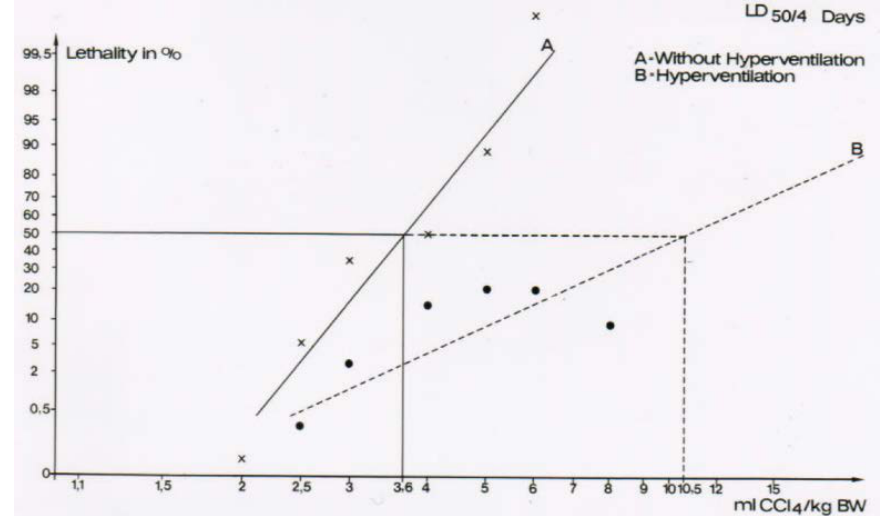
Figure 14. The lethal dose (LD) was determined as LD 50 for 4 days, with 3.6 ± 0.5 mL CCl 4 per kg body weight for the non-hyperventilated animals versus 10.5 ± 3.0 mL CCl 4 per kg body weight for the hyperventilated animals. The difference was statistically significant using the chi-square test ( p = 0.015), reproduced with permission from [44,45]. Copyright Wiley, 1982 and Springer, 1982.